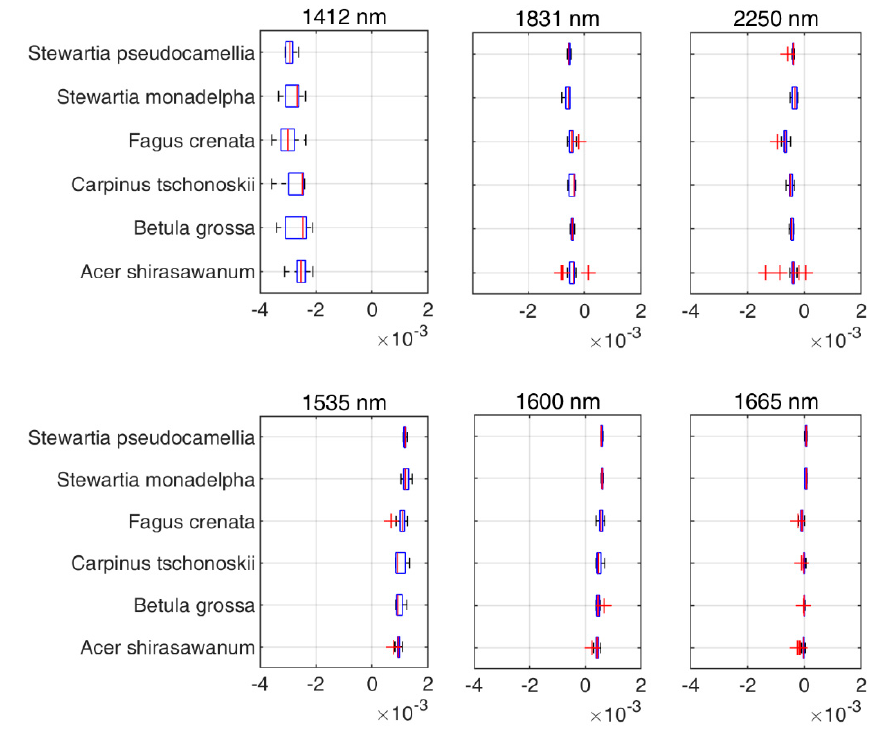
Figure 8. Value range of first-order derivatives spectra for the DDn selected wavelengths.